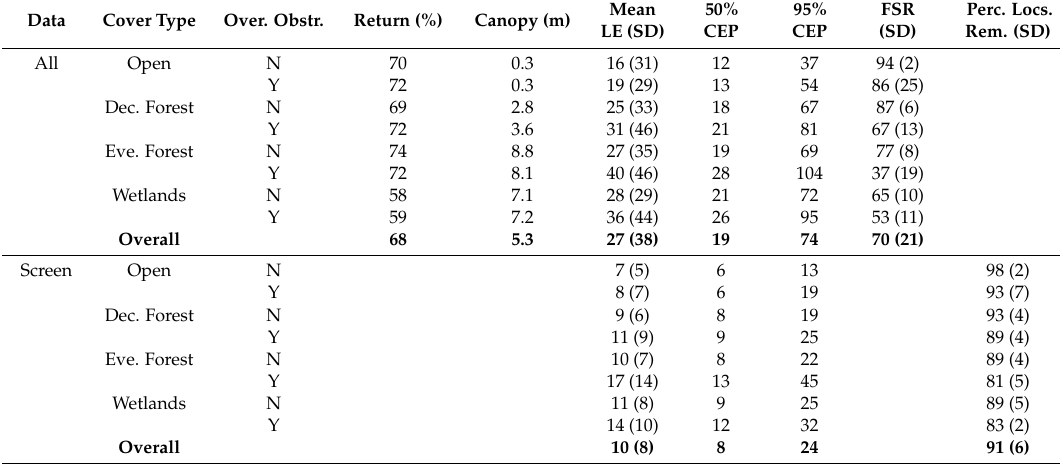
Table 1. Summary of all and screened global positioning system (GPS) stationary test data in northeastern Minnesota. Tests were at four different National Land Cover Database cover types, including developed/opening (Open), deciduous forest (Dec. Forest), evergreen forest (Eve. Forest), and woody wetlands (Wetlands). An overhead obstruction (Over. Obstr.) at half of the sites simulated turtle hiding behavior. Percentage of laser returns >15 cm (Return) and mean canopy height (Canopy) were calculated from a 50 m circular buffer around each location using light detection and ranging (LiDAR) data. Mean location error (LE), 50% and 95% circular error probable (CEP), the percentage of successful locations (FSR), and the percent of locations (Perc. Locs. Rem.) kept after screening outliers are